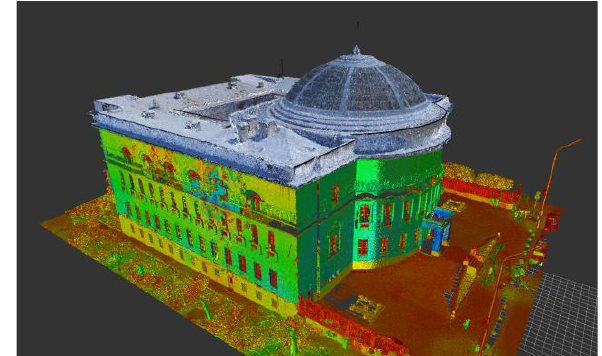
Figure 3 . Fusion of TLS and photogrammetry point clouds of Kyiv Teacher’s House